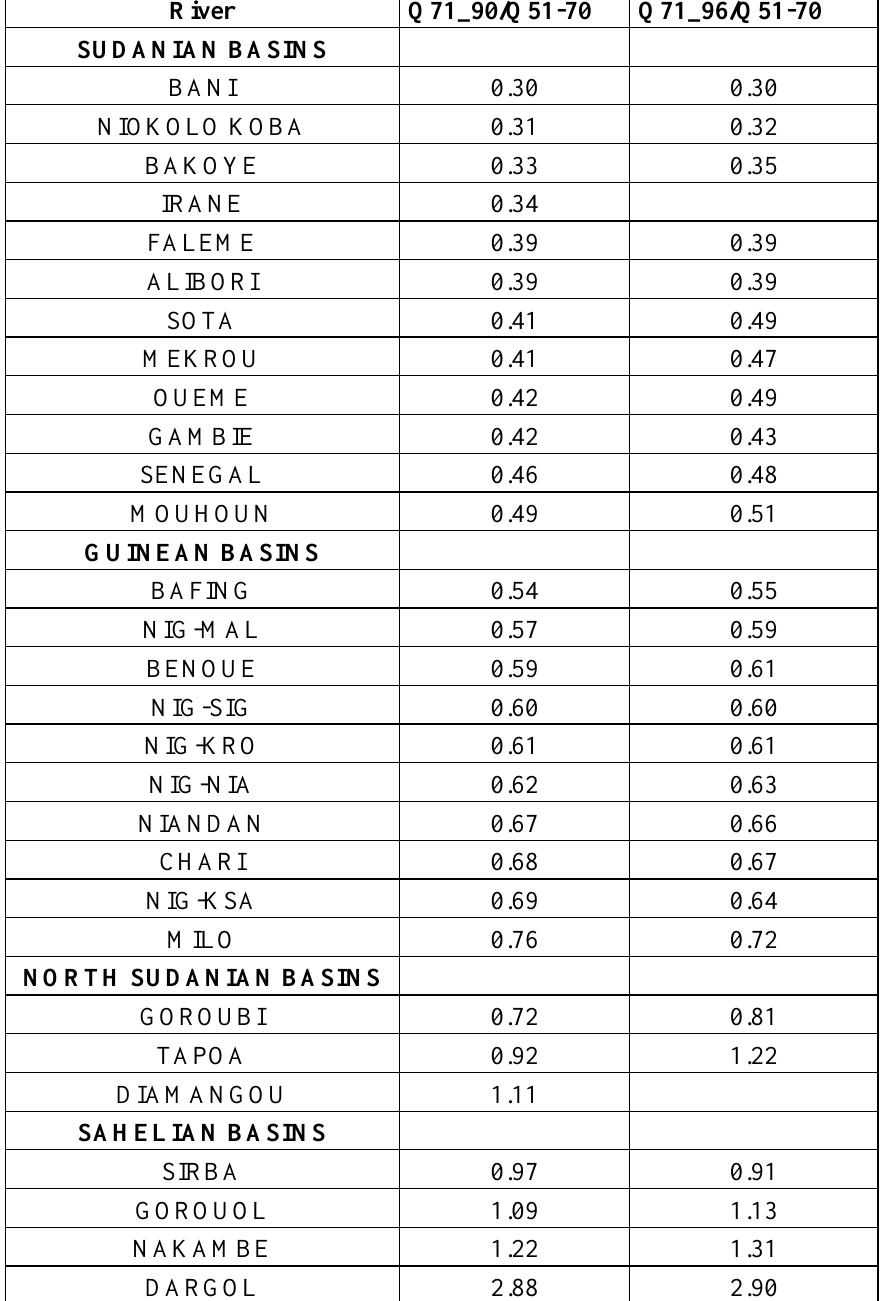
Table 10. Relative values of total annual discharge for the periods 1971–1990 and 1971–1996 vs. the period